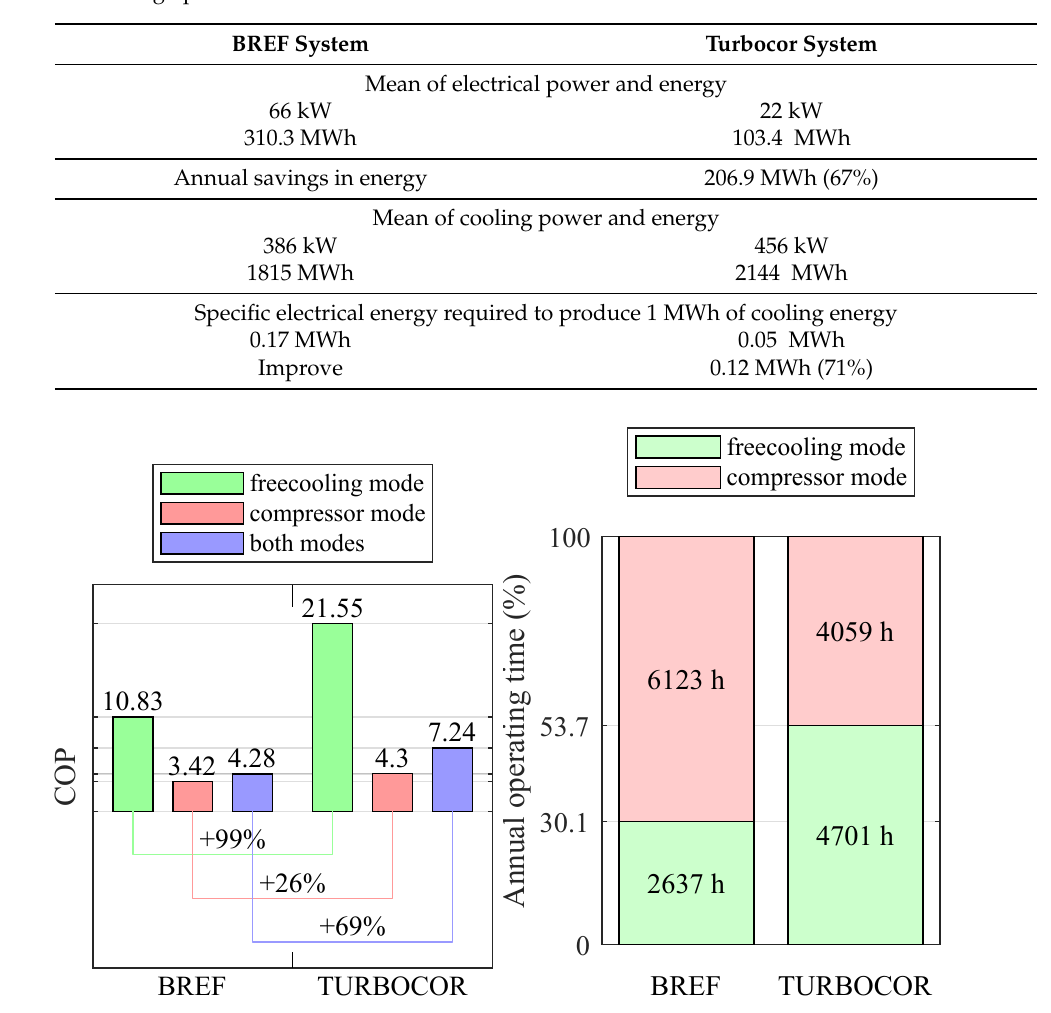
Figure 24. Annual COP and operating